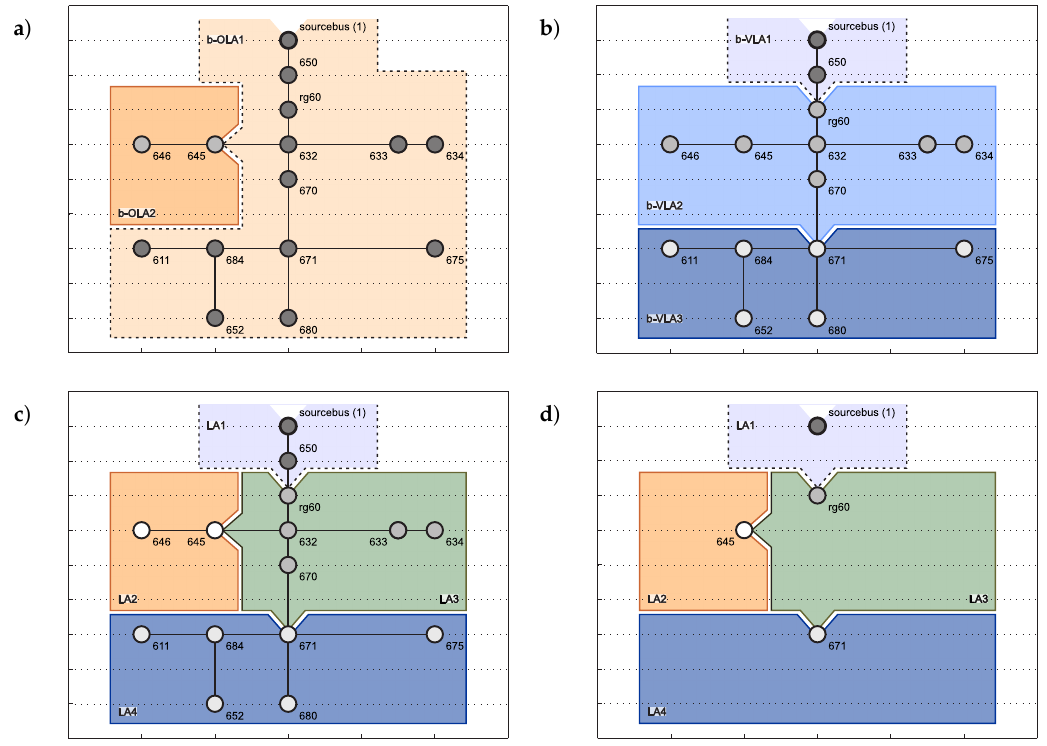
Figure 9. Small-size grid—( a ) b-OLAs; ( b ) b-VLAs; ( c ) b-LAs; and ( d ) compact representation by